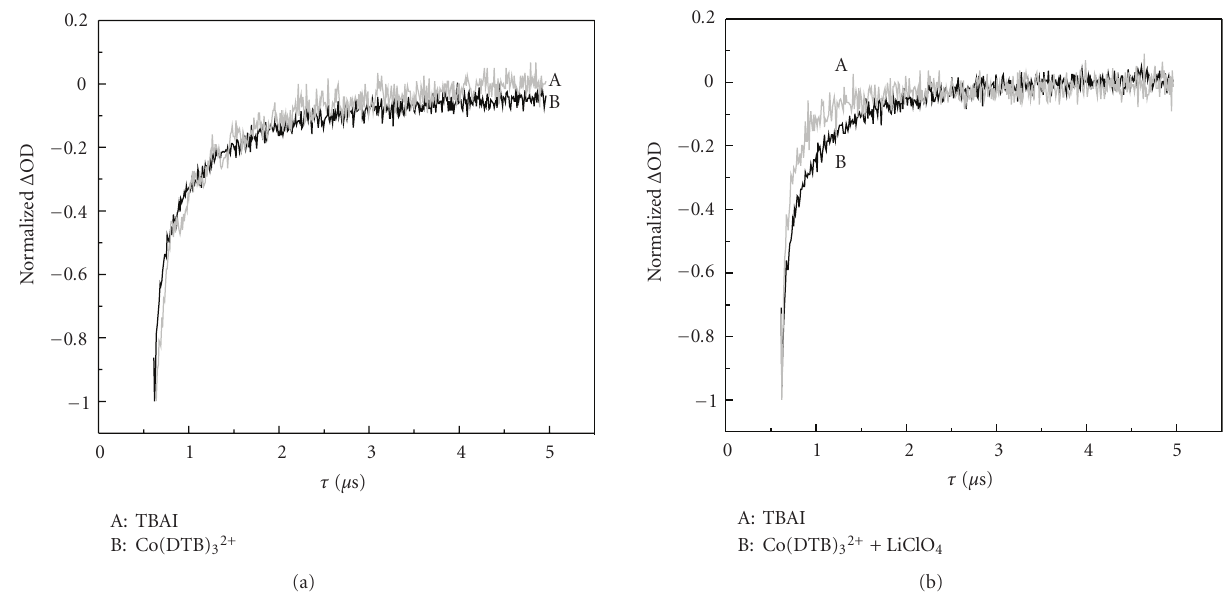
Figure 10: 480nm Ru(III)(H 2 DCB) 2 (NCS) + (b) Tetrabutyl-ammonium iodide (A) and Co(DTB) 2+